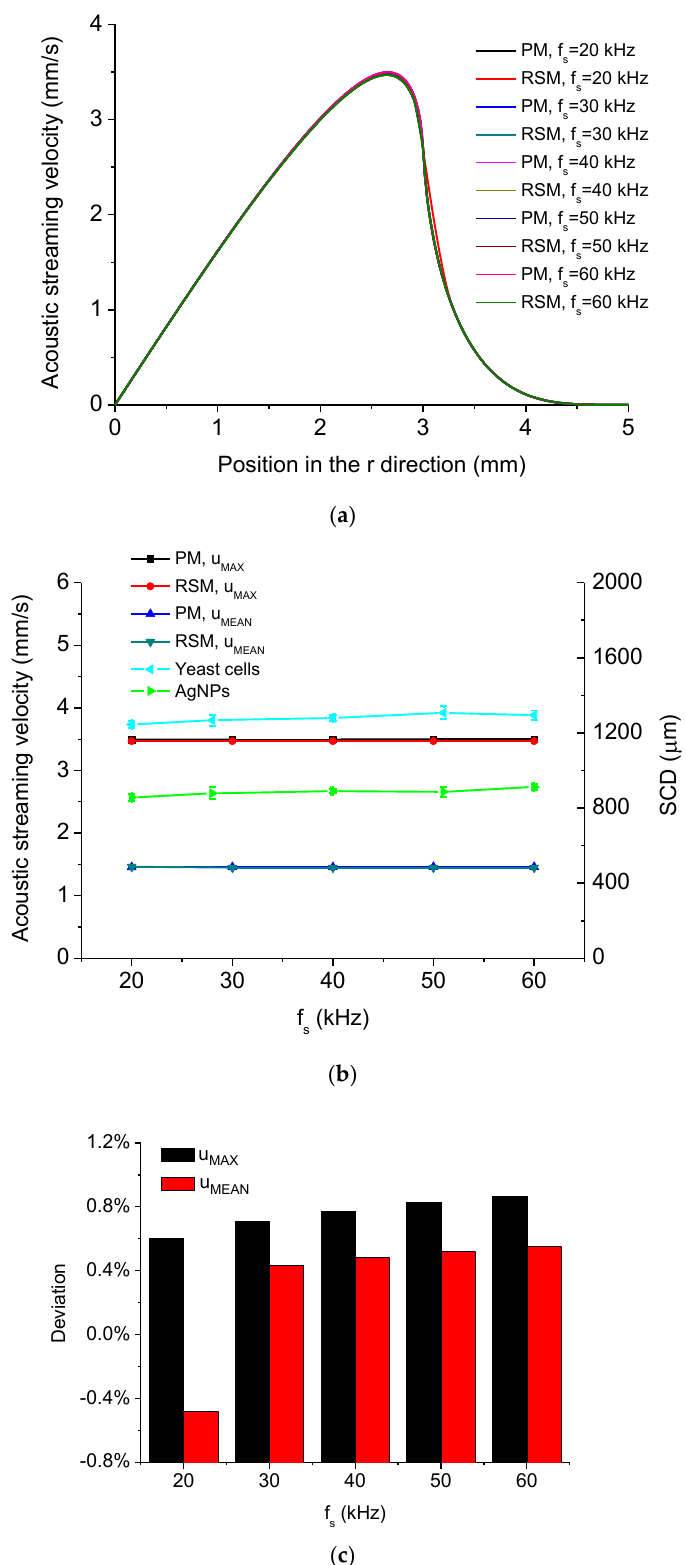
Figure 12. ( a ) Computed acoustic streaming velocity magnitude distribution along the r direction at the droplet-substrate interface in the droplet-ultrasonic substrate system under different f s . ( b ) u MAX , u MEAN and SCD versus f s in the droplet-ultrasonic substrate system. ( c ) Deviations of u MAX and u MEAN computed by the PM and RSM versus f s in the droplet-ultrasonic substrate